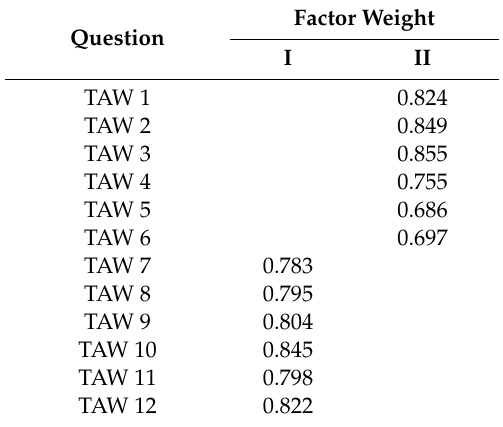
Table 2. Exploratory factor analysis (EFA) results of the thriving at work (TAW)